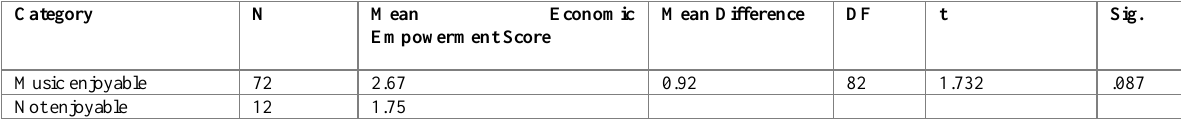
Table 5: Influence of Style of Worship Policy on Youth Economic Empowerment